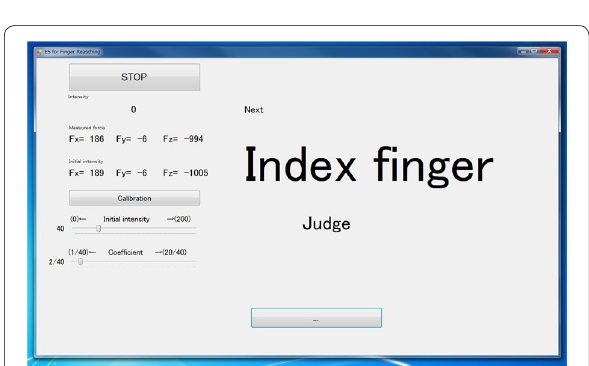
Fig. 7 Second group condition, cannot see left